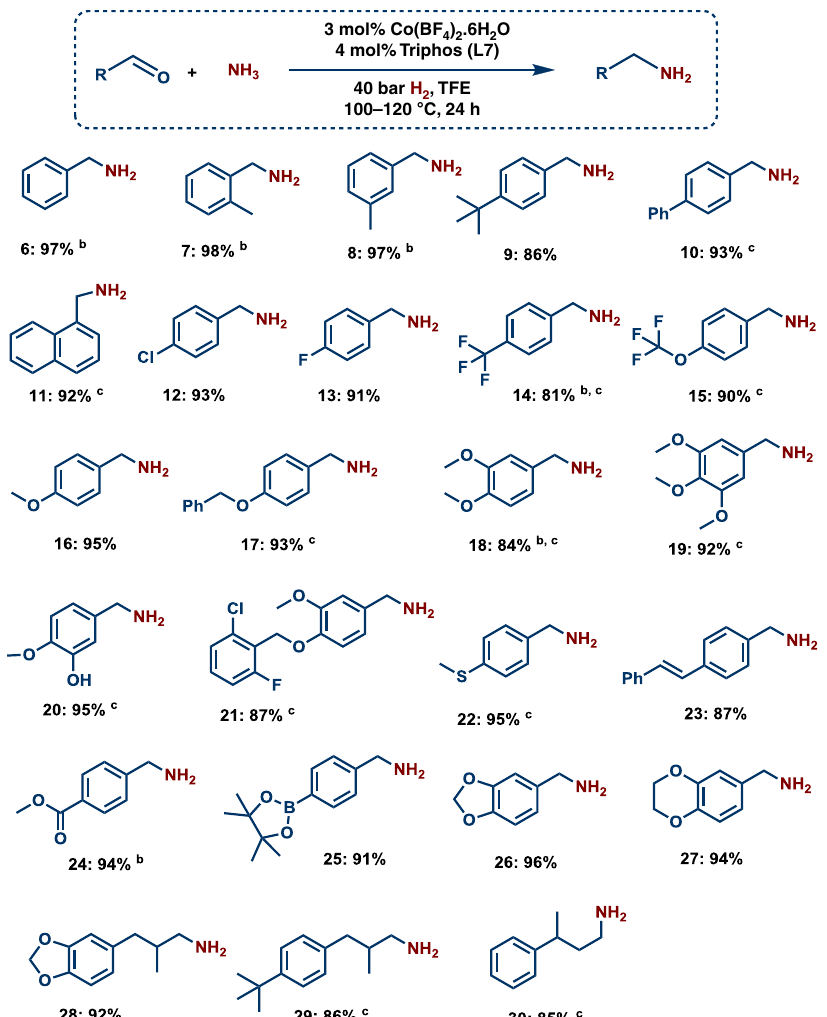
Fig. 1 Cobalt-triphos catalyzed synthesis of primary amines from aldehydes. Reaction conditions: a 0.5 mmol aldehyde, 3 mol% Co(BF 4 ) 2 .6H 2 O, 4 mol% triphos ( L7 ), 5 – 7 bar NH 3 , 40 bar H 2 , 2 mL degassed TFE, 100 °C, 24 h. b GC yields using n-hexadecane as standard. c Same as ‘ a ’ at 120 °C. Isolated as